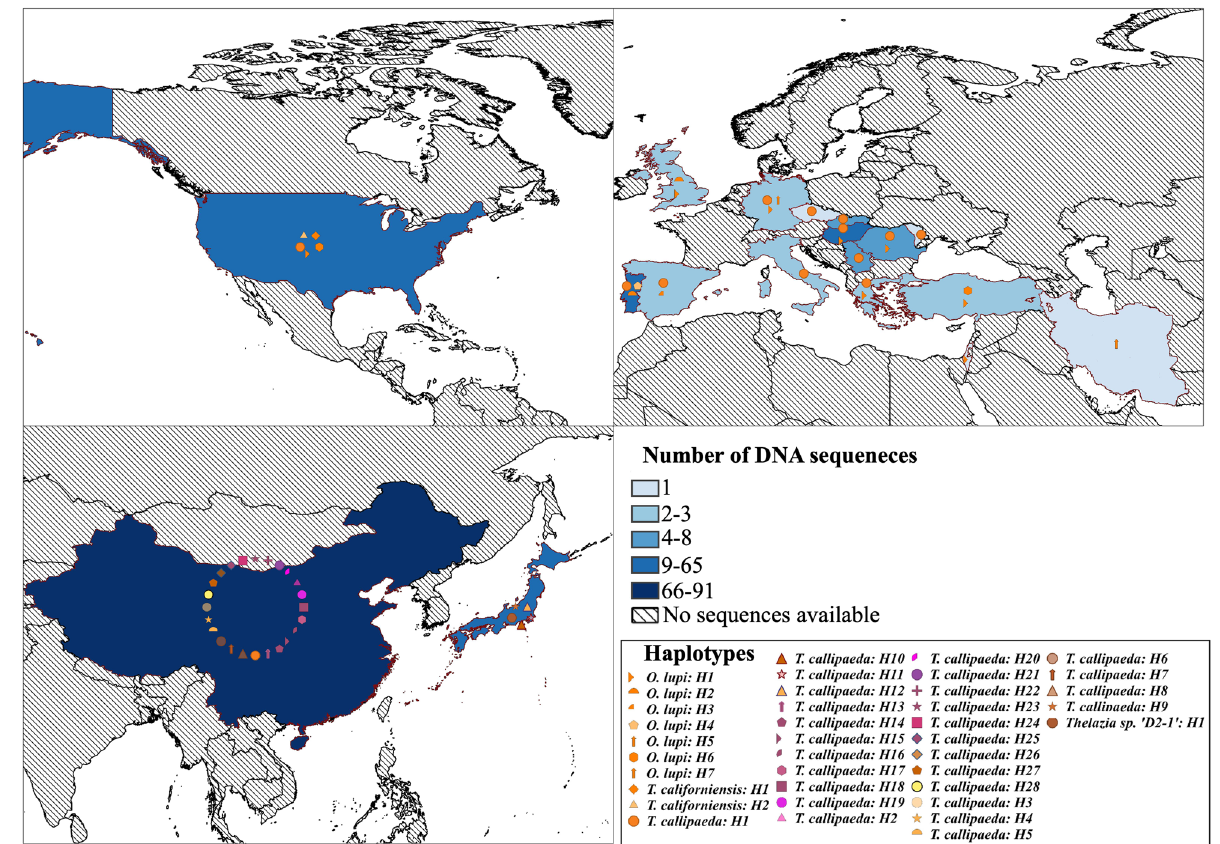
Figure 4. Geographical plotting of the zoonotic eye-worms ( Thelazia spp. and O. lupi ) haplotypes using the QGIS software (version 3.0.0, http:// qgis. osgeo. org) 25 . The choropleth map (color-gradient map) represents the availability of DNA sequences per each country. Haplotypes for each species are plotted using country centroids and the point displacement